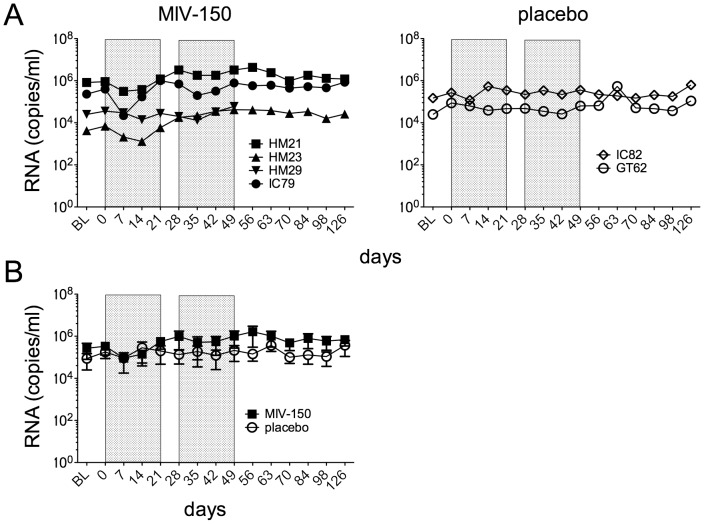
Plasma viral load in animals after systemic administration of MIV-150.Plasma virus levels were measured in the MIV-150 vs. placebo-treated animals over time. Viral load for individual animals is shown in A and mean viral loads (±SEM) are shown in B for the two treatment groups. The shaded areas indicate periods of daily injections.